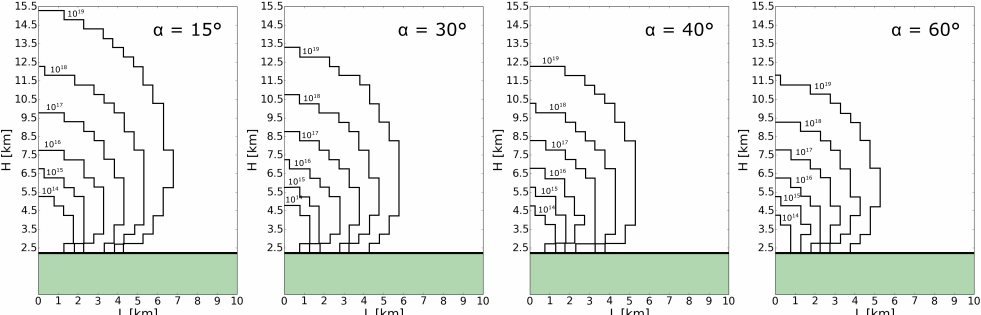
Figure 9. Detectability regions corresponding to TGFs with different initial numbers of seeds N 0 = 10 14 , 10 15 ,10 16 ,10 17 ,10 18 ,10 19 , and different emission half-angles α = 15 ◦ ,15 ◦ ,40 ◦ ,60 ◦ . It can be noticed that the number of survived photons at the detector is proportional to the number of initial seeds N 0 and inversely proportional to the emission half-angle α